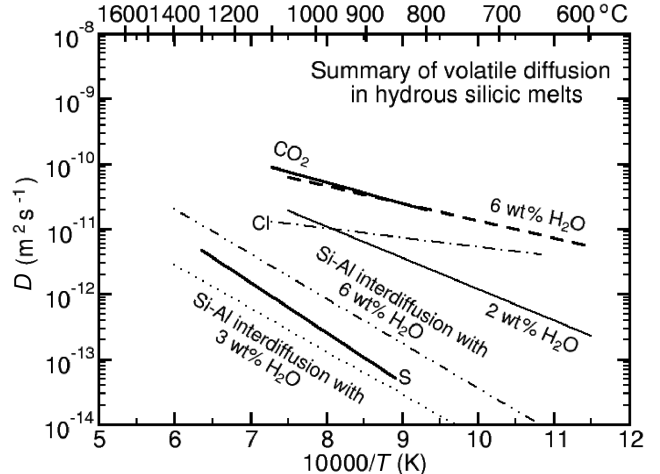
Fig. 6. Comparison of volatile diffusion in hydrous silicic (almost exclusively rhyolitic) melts. Water diffusion, for 2 and 6 wt% total, is calculated from Zhang and Behrens (2000). CO 2 diffusion is calculated from Watson (1991) in a melt with 8 wt% dissolved water. S diffusion is a combination of the high-temperature results of Wat- son et al . (1993), see also Watson (1994), and the low-temperature results of Baker and Rutherford (1996). Cl diffusion is a combination of the high temperature results of Watson (1991) and the low temperature results of Bai and Koster van Groos (1994). Note that the apparent activation energies for S and Cl diffusion may be an artifact of combining data from two different studies. Lines for Si-Al interdiffusion in silicic melts containing either 3 or 6 wt% H 2 O are extrapolated using the Arrhenius relationships determined by Baker